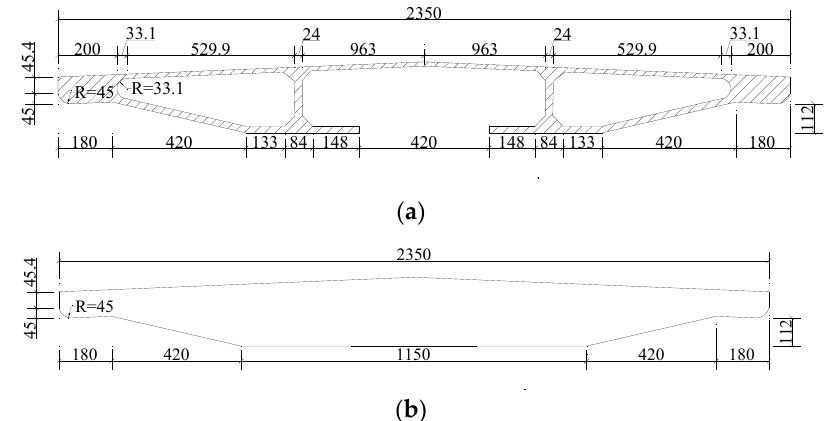
Figure 5. Section type: ( a ) Open box section; ( b ) Solid section.